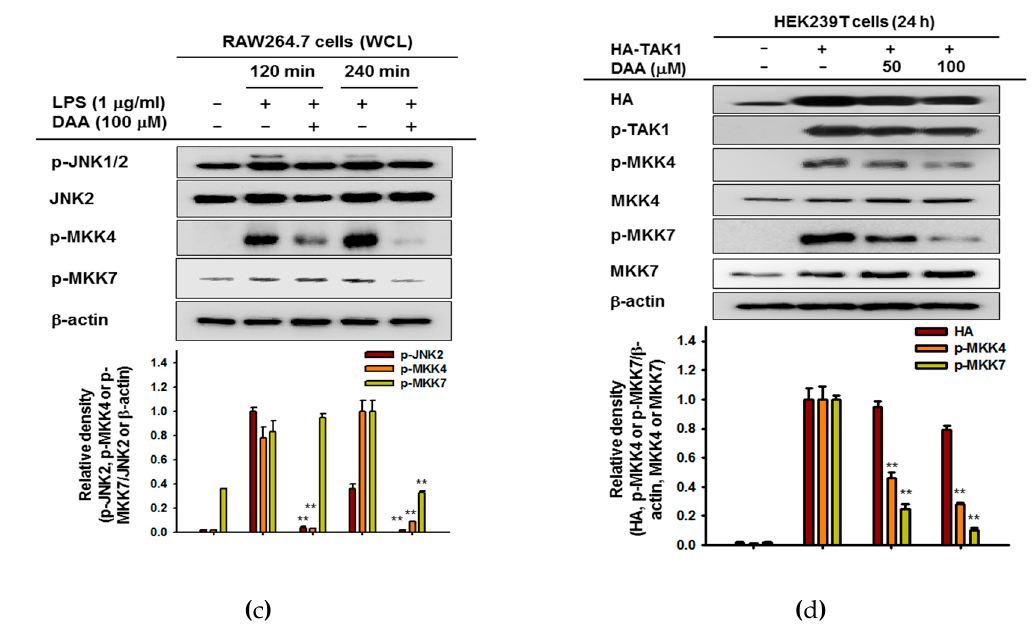
Figure 5. Effect of DAA on the AP-1 cascade. ( a–c ) DAA-pre-treated RAW264.7 cells were exposed to LPS (1 µg/mL) time-dependently, and whole-cell lysates were prepared. Phosphorylated or total levels of p38, c-Jun N-terminal kinase (JNK), extracellular signal-regulated kinase (ERK). mitogen-activated protein kinase kinase 4 (MKK4), MKK7, transforming growth factor beta-activated kinase 1 (TAK1), and β -actin were determined by immunoblotting. ( d ) TAK1-transfected HEK293T cells were treated with DAA (0–100 µ M) for 24 h. Whole-cell lysates of cells were prepared, and phosphorylated or total forms of TAK1, MKK4, MKK7, HA, and β -actin were detected by immunoblotting. Relative intensity ( b , c ) was the calculated ratio using densitometric scanning values of phospho-proteins and densitometric scanning values of β -actin, HA or total forms of proteins from blots observed with independent repeats ( n = 3) by the DNR Bio-imaging system (Gelquant software Version 2.7). ** p < 0.01 compared to the induced group.